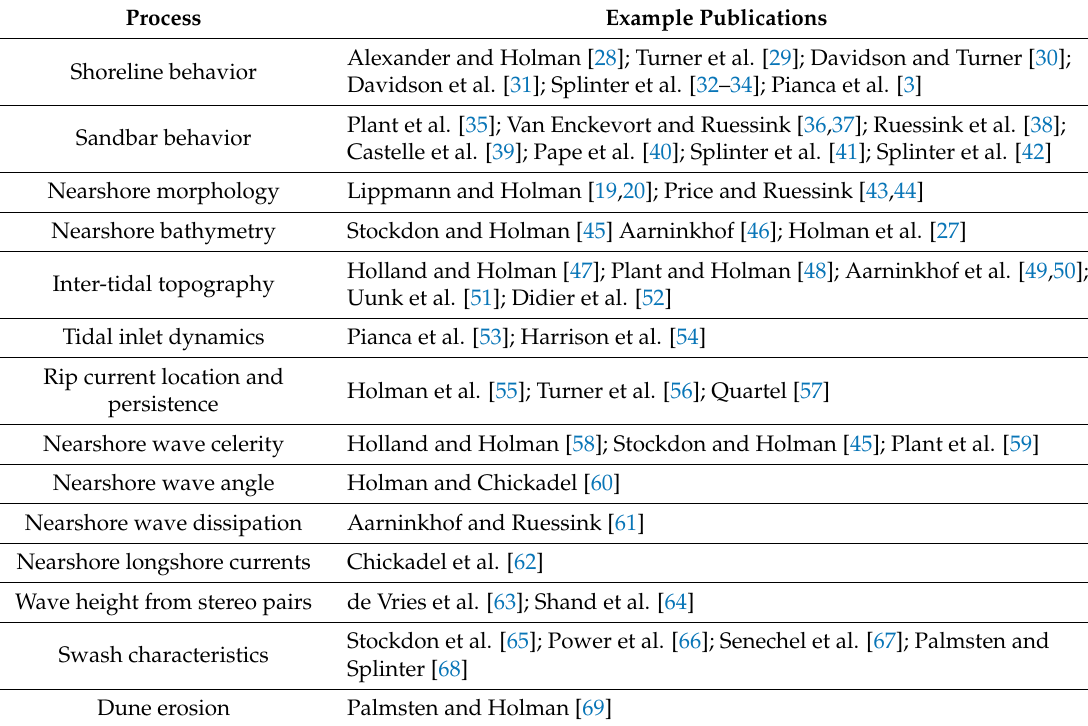
Table 1. Key international research outcomes provided by video remote